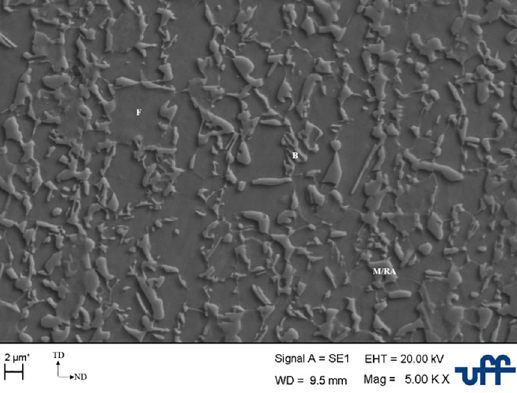
Figure 3. TRIP780 steel as-received microstructure observed by scanning electron microscopy (ND – Normal Direction and TD – Transverse Direction).